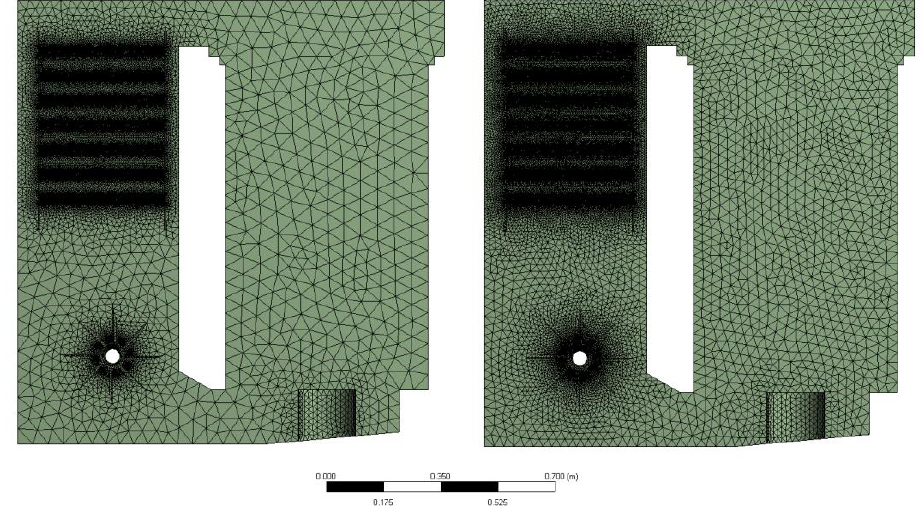
Figure 5. Grid systems ( a ) coarse mesh, 1.5 million cells, and ( b ) fine mesh, 3 million cells.